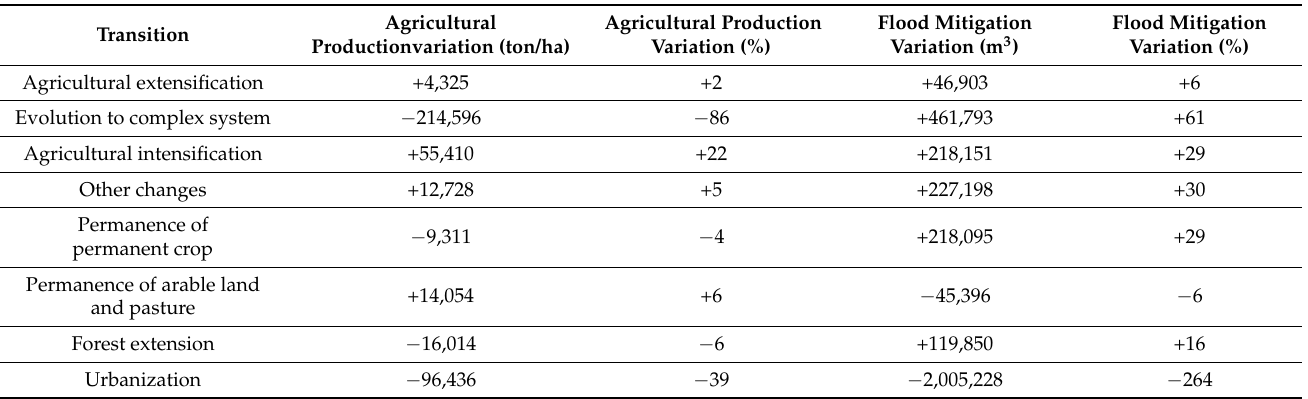
Table 3. Agricultural production (ton/ha) and flood mitigation (m 3 ) variation in arable land, vineyard, olive groves, and orchards, between 1990 and 2018. The percentage was calculated by dividing the variation of individual transition processes by the total sum of each ES